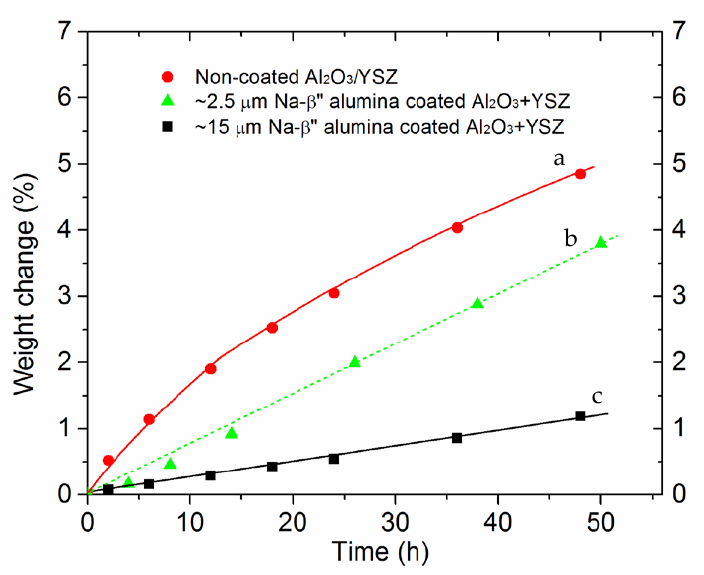
Figure 7. Comparison in weight change for ( a ) uncoated, ( b ) ~2.5 μm Na- β ”-alumina-coated, and ( c ) ~15 μm Na- β ”-alumina-coated samples as a function of conversion time at 1250 °C.